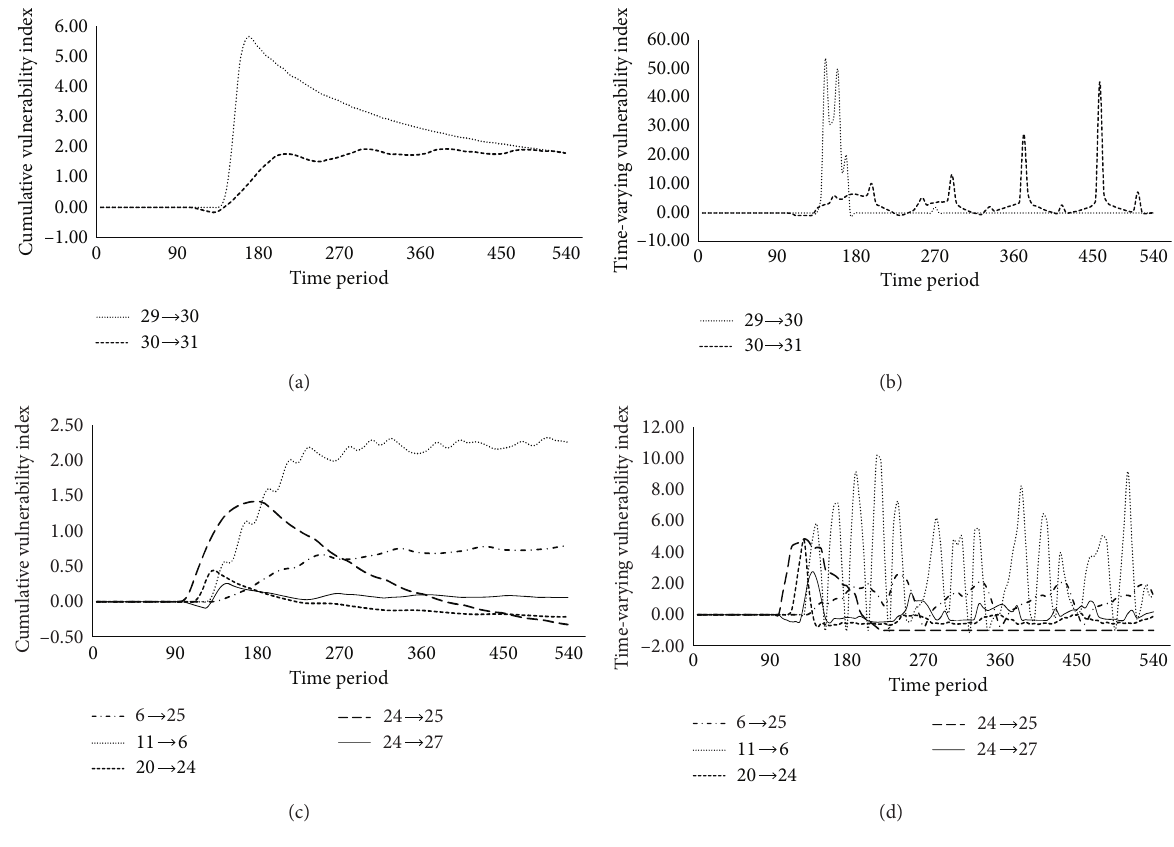
Figure 8: Individual link vulnerability variation. (a, b) Cumulative and time-varying vulnerability under severe impact. (c, d) Cumulative and time-varying vulnerability under general impact. (a) Cumulative vulnerability under severe impact. (b) Time-varying vulnerability under severe impact. (c) Cumulative vulnerability under general impact. (d) Time-varying vulnerability under general